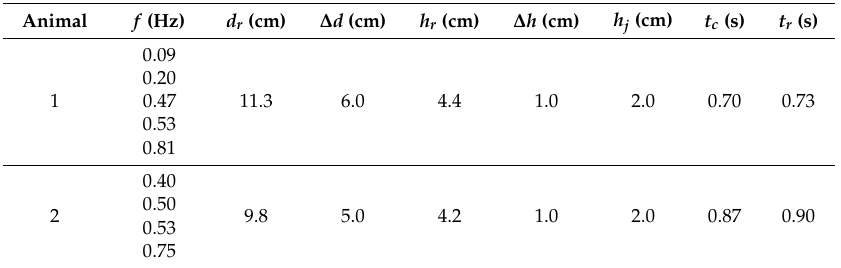
Table 2. Input parameters for the hydrodynamic model. Parameters include measured swimming frequency ( f ), relaxed bell diameter ( d r ), maximum change in diameter between relaxation and contraction states ( ∆ d ), relaxed bell height ( h r ), maximum change in height between contraction